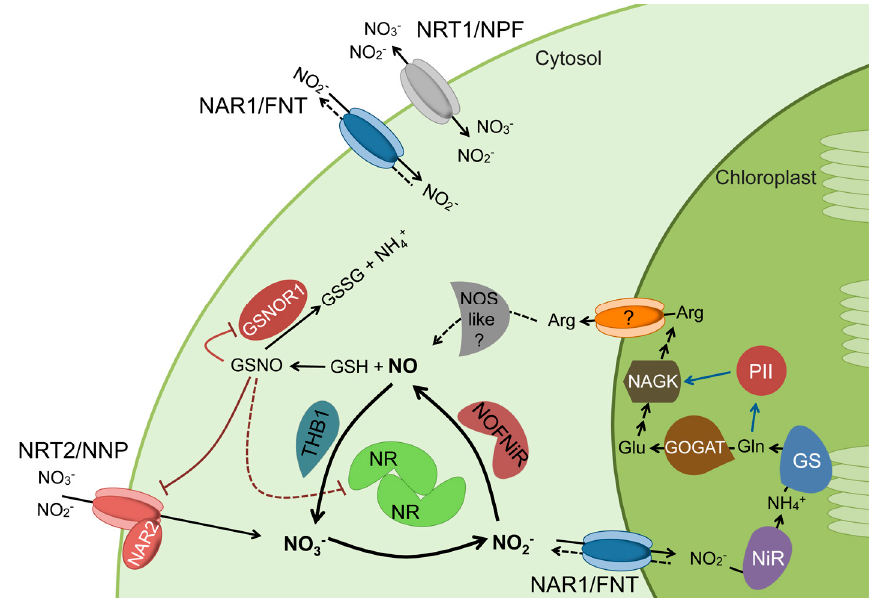
Figure 1. The schematic model for the coordinated regulation of Nitric Oxide (NO) synthesis and N metabolism. Blue arrows indicate activation and red lines indicate inhibition by trans-nitrosylation. Dashed lines represent hypothetical steps. The NOS-like component represents the L-Arg-dependent NOS activity reported in different plant species .